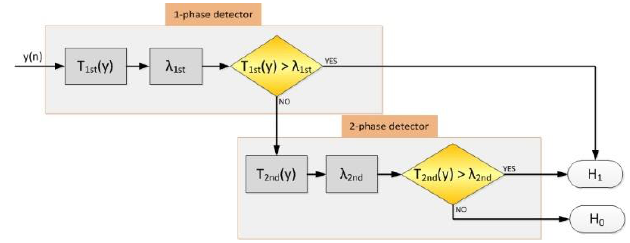
Figure 1. Scheme of the hybrid